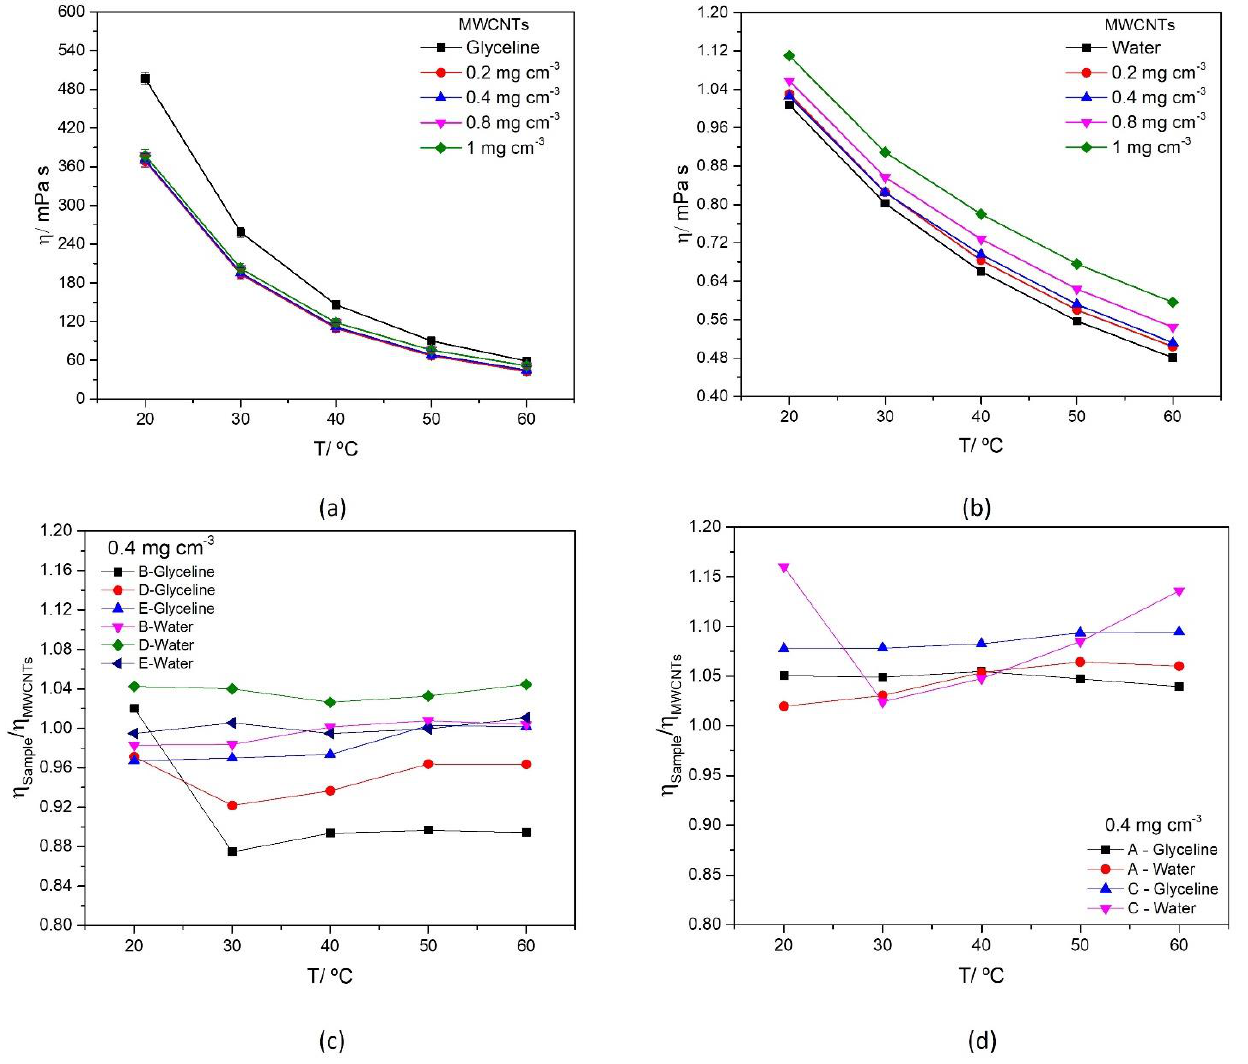
Figure 4. Dynamic viscosity of MWCNTs mixtures (0.2–1.0 mg cm − 3 ) in glyceline ( a ), water ( b ) as a function of temperature, and dynamic viscosity ratio of AgMWCNTs (0.4 mg cm − 3 ) Samples B, D and E ( c ), A and C ( d )) as a function of temperature, in glyceline and water.